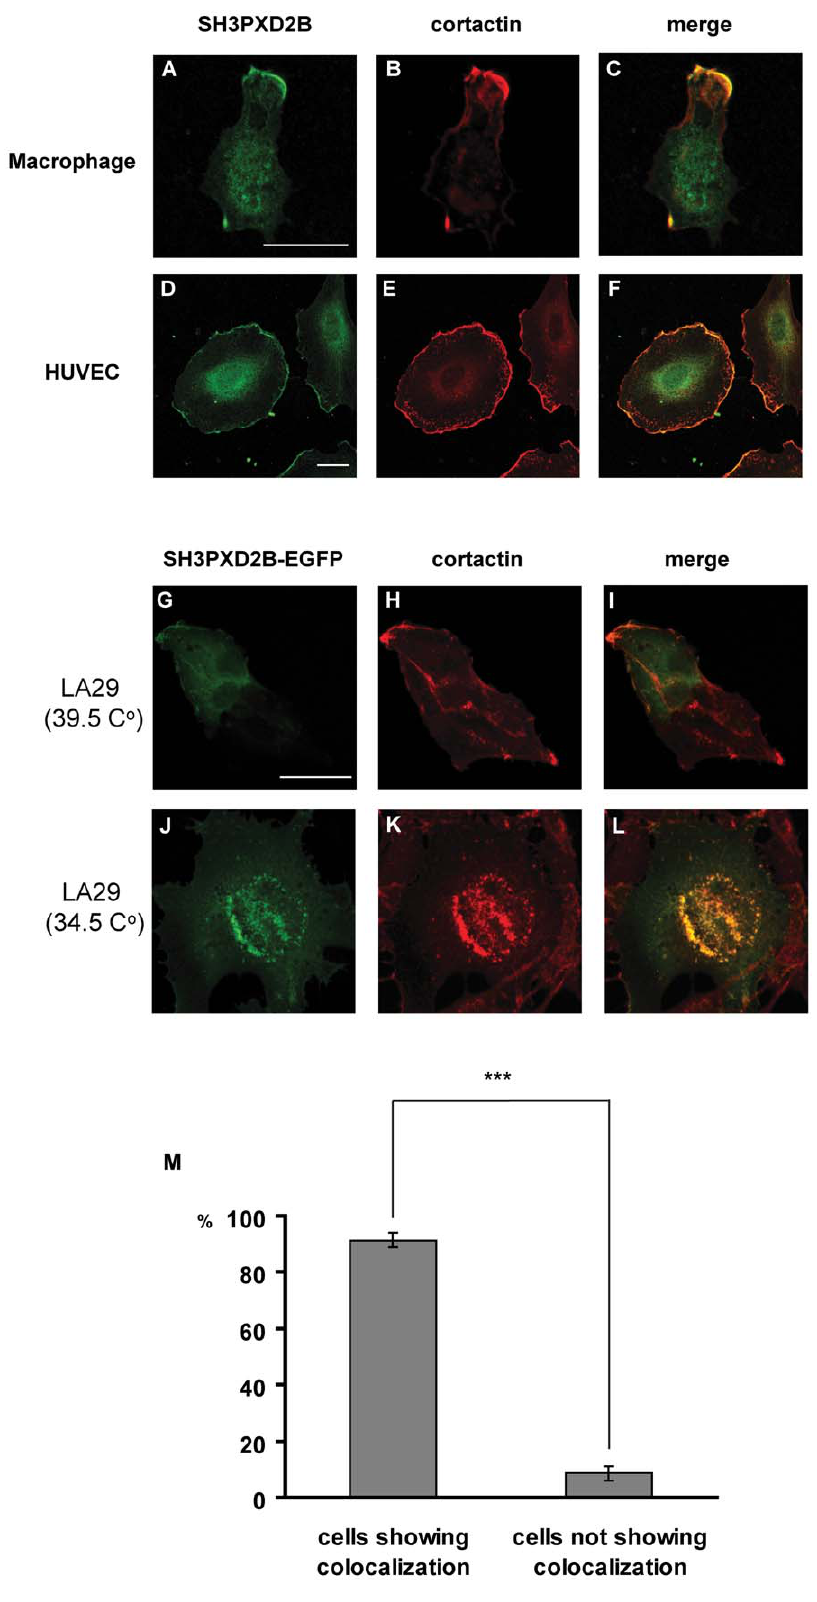
Figure 3. Co-localization of SH3PXD2B with cortactin in HUVEC, macrophages and LA29ts fibroblasts. Human monocyte-derived macrophages ( A–C ), HUVEC ( D–F ) were stained as described for Figure 2A–F. ( G–L ) Rat-1 LA29 fibroblast cells carrying a temperature sensitive mutant form of Src were grown on coverslips and transfected with an SH3PXD2B-EGFP construct. Cultures were kept at the nonpermissive